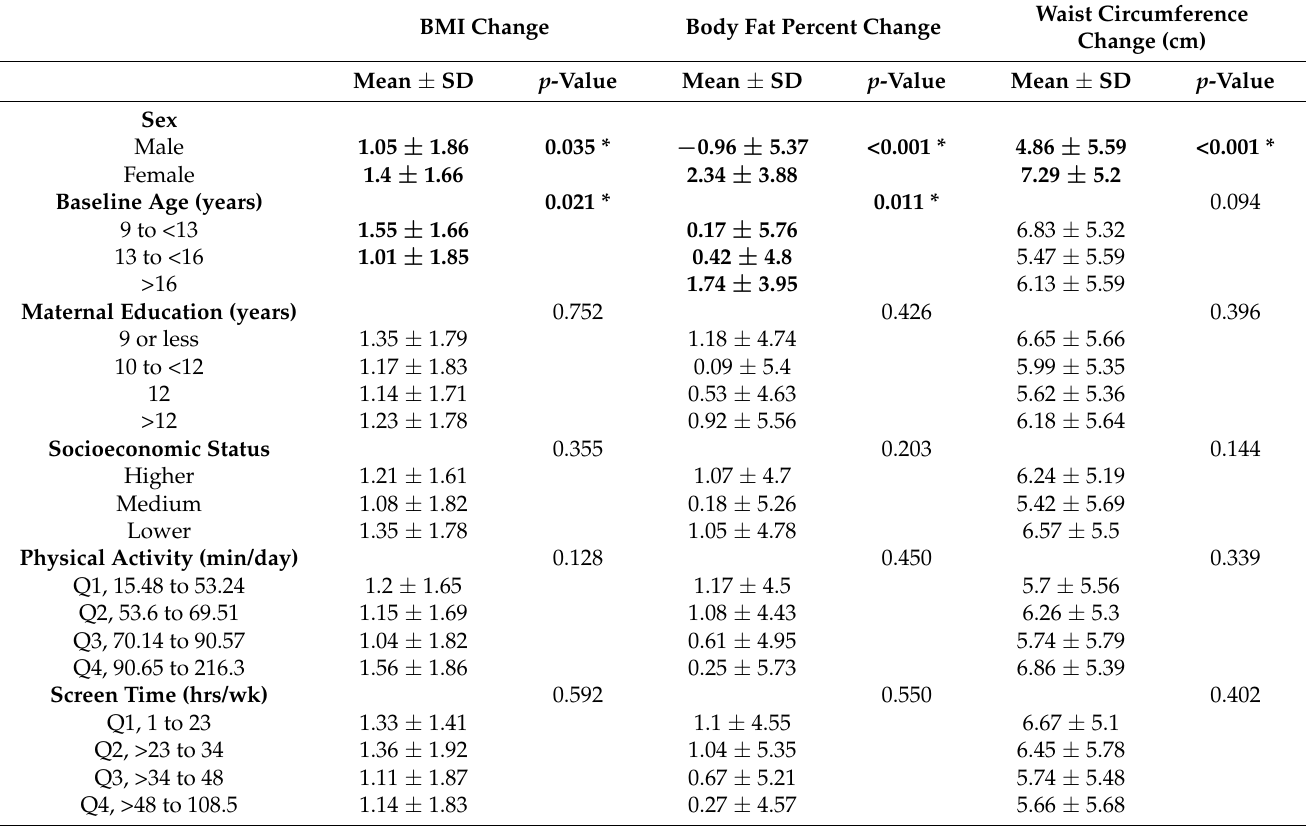
Table 2. Body composition changes from 2015 to 2017 by baseline characteristics ( n =